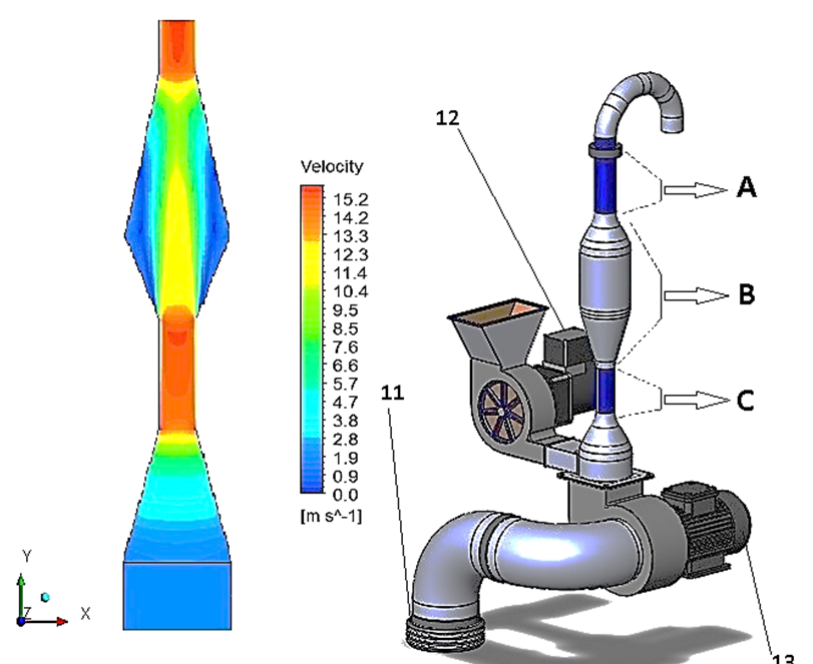
Figure 2. Variation of linear speed over the entire section of the tube with three